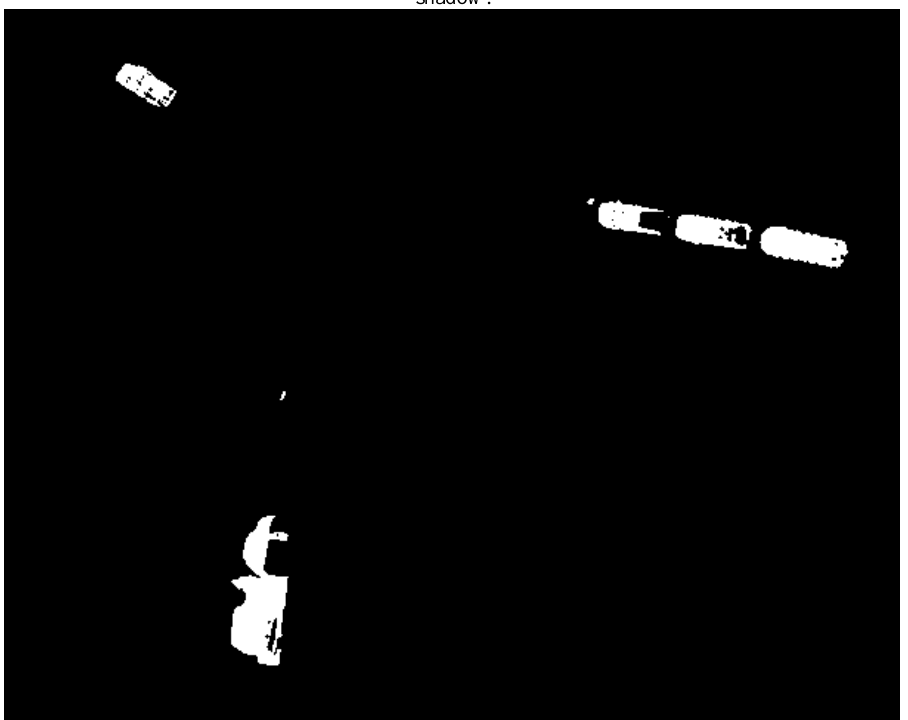
Figure 6B. This Figure shows the result after filtering above Figure, and the algorithm still couldn’t distinguish between the vehicle and its